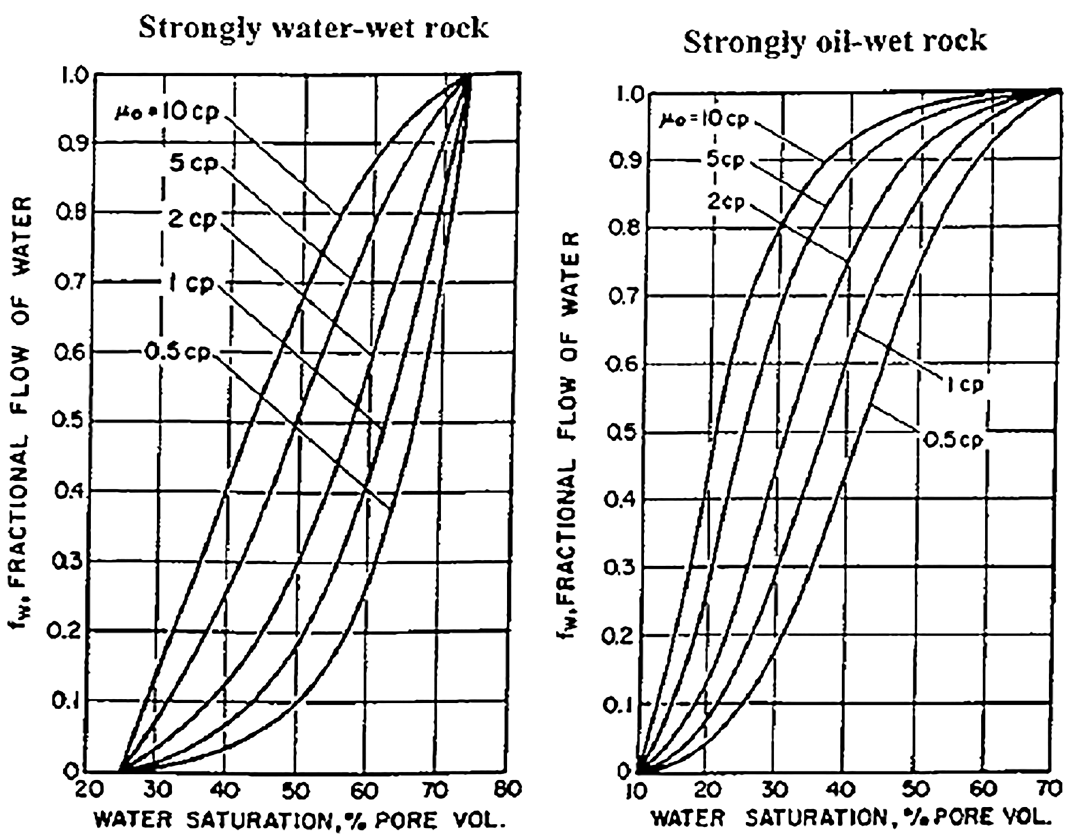
Fig. 5 Effect of oil viscosity on fractional flow curve (Tarek 2010)